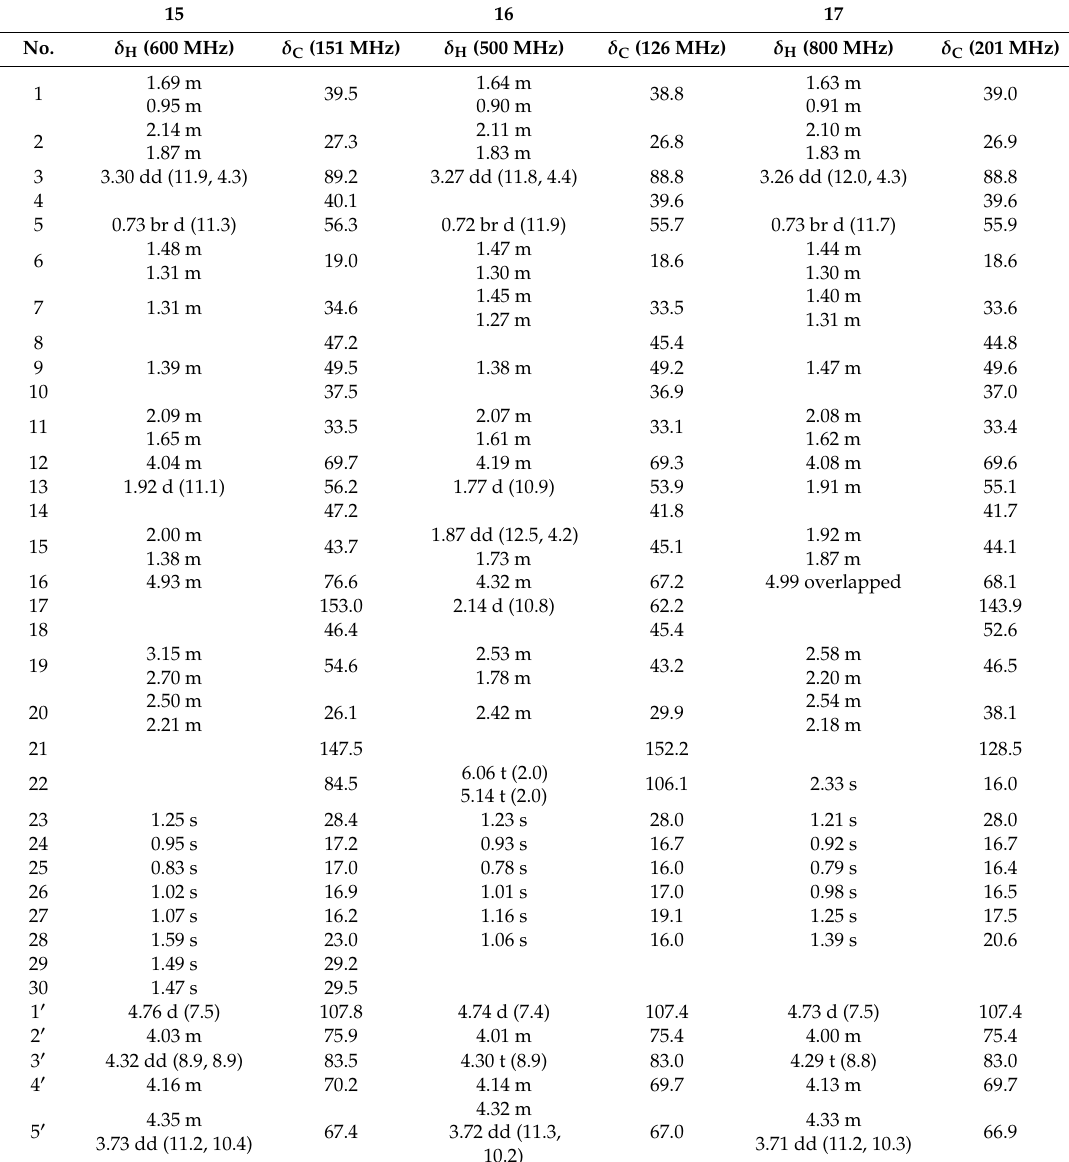
Table 6. 1 H and 13 C-NMR data of 15 – 17 in Pyridine- d 5 ( δ in ppm, J in